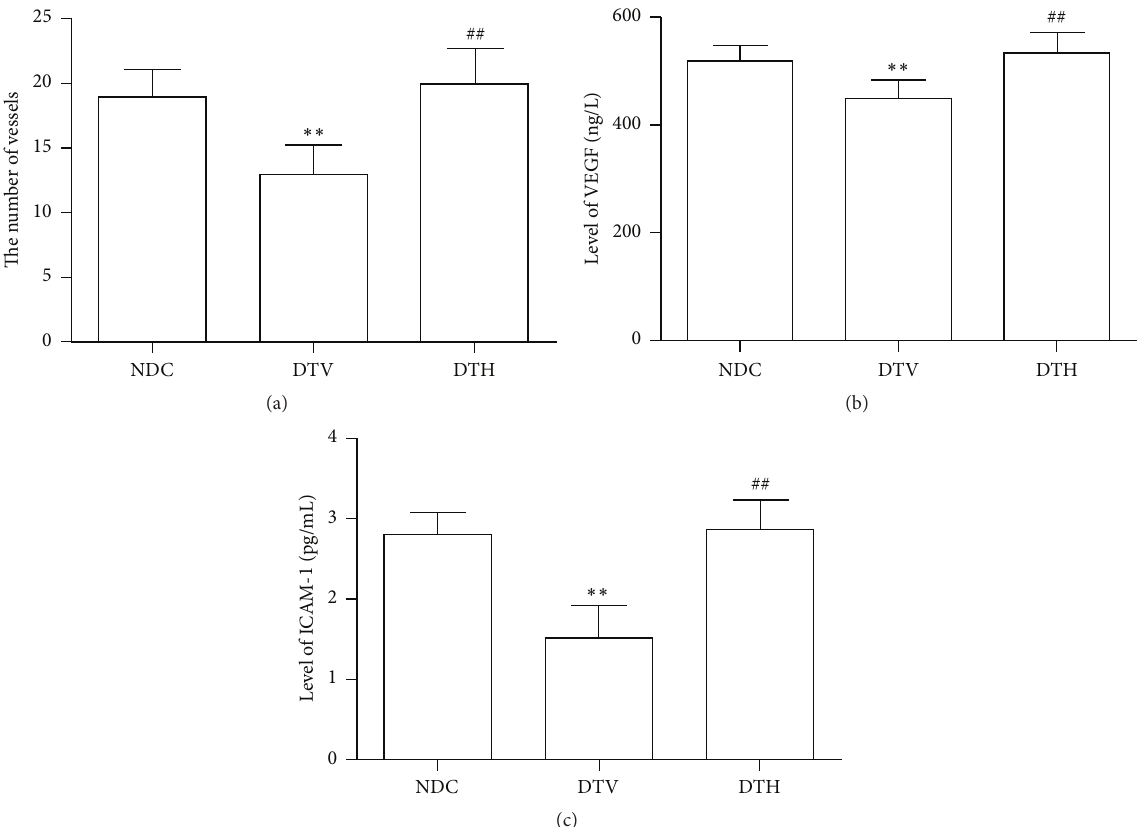
Figure 4: HO-1 ameliorated angiogenesis in granulation tissues from diabetic wounds. (a) The number of vessels was increased in granulation tissues from diabetic wounds treated with hemin ( ∗∗ 𝑃 < 0.01 versus NDC; ## 𝑃 < 0.01 versus DTV). ((b) and (c)) HO-1 increased levels of VEGF and ICAM-1 in serum from diabetic rats ( ∗∗ 𝑃 < 0.01 versus NDC; ## 𝑃 < 0.01 versus